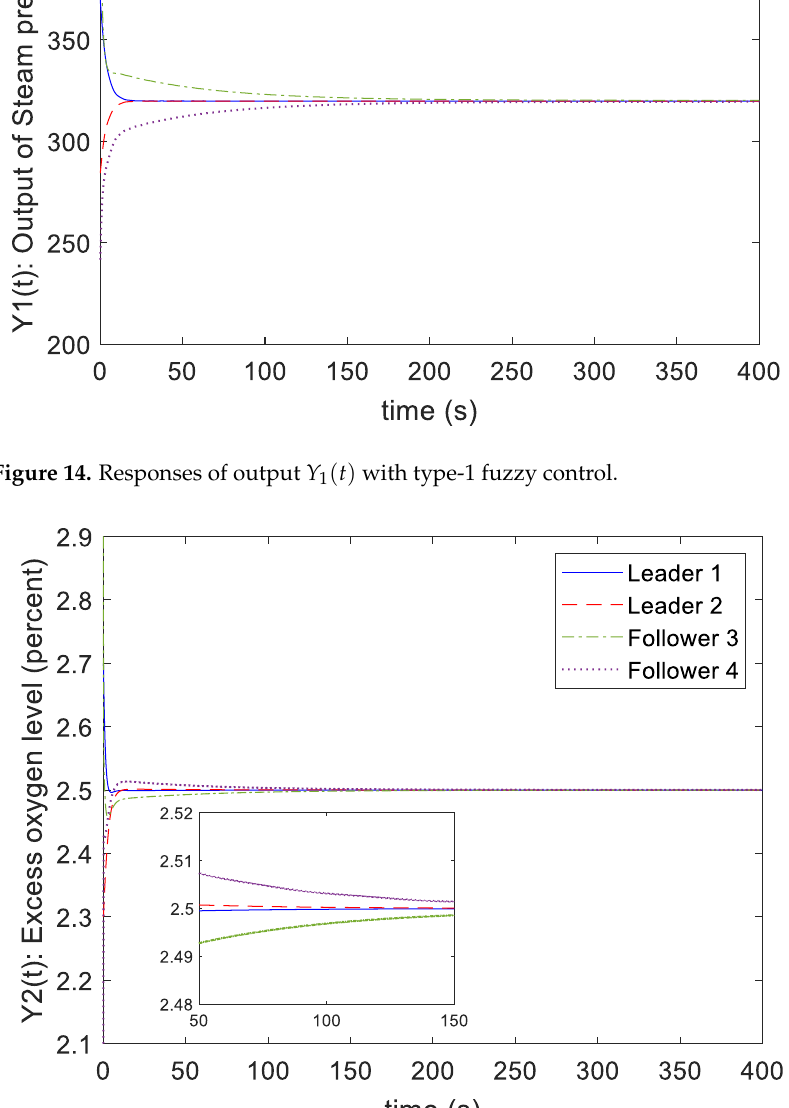
Figure 15. Responses of output Y 2 ( t ) with type-1 fuzzy control. From Figures 14–17, it is obvious that the overshoots of each output are bigger than the responses obtained by the proposed IT-2 fuzzy control method in Figures 9–12. Moreover, there are a non-smooth process of followers when they are forced to the desired place by leaders in Figure 14. The convergent rate of Y 2 ( t ) obtained in Figure 15 is also much slower than the responses obtained in Figure 10. According to the above comparison results, the difference between the responses obtained by the type-1 fuzzy and IT-2 fuzzy control method is caused by the uncertainties in the nonlinear multi-boiler system (1)–(8). For the multi-agent system, the problem of uncertainties might be much more serious than that of a single system. When the information of states communicated between agents is affected by uncertainties, the error of the accepted value from neighbor agents will become